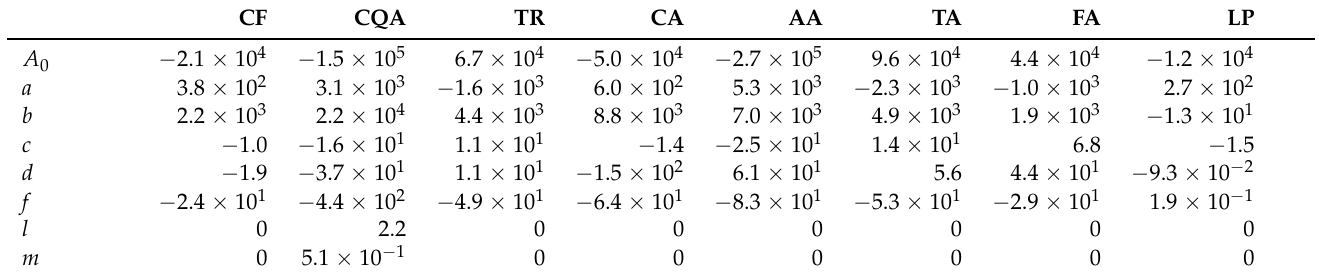
Table A5. Coefficients of the dissolution rate α r , v coarse granulometry r = C and Robusta variety v = R.